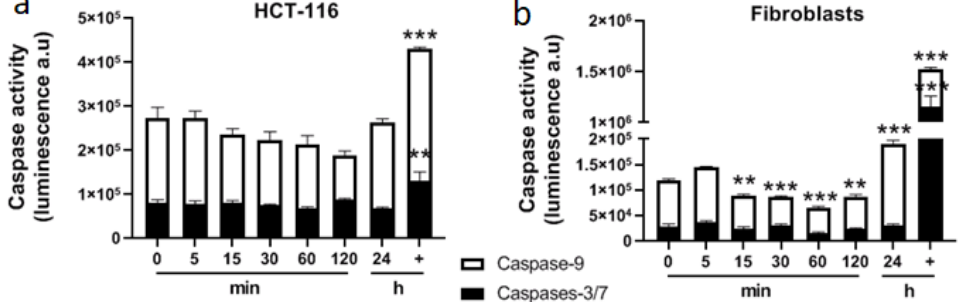
Figure 7. Determination of caspases’ activities after 5 mM calcium electroporation in HCT-116 tumor cells ( a ) and normal dermal fibroblasts ( b ). Caspase-9 and caspases-3/7 were quantified by luminescence. + indicates the positive control (incubation overnight with staurosporine 1 µM). Each value represents the mean ± SEM of at least two independent experiments led in quadruplicate. Statistical differences were analyzed by one-way ANOVA followed by a Dunnett’s post-test in comparison to the control condition (0 min). ** p ≤ 0.01; *** p ≤ 0.0001.